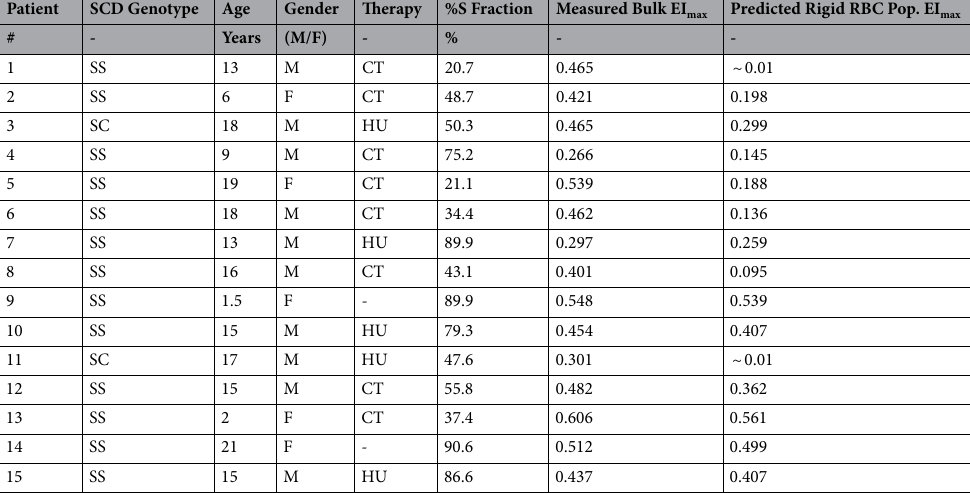
EIs obtained for healthy blood samples and the predicted maximum EIs of only the HbS (rigid) fraction for each patient’s blood. We observed a very narrow range in maximum EI of healthy blood measurements, while a maximum EIs of the raw SCD patient and healthy blood. From this data, we calculated ratios that compare the estimated maximum EIs of the sickle population in the patient blood samples to (1) the maximum EI in a healthy blood sample and (2) the maximum EI of the bulk SCD patient blood sample. A ratio value higher than unity suggests that the maximum EI of the rigid RBC population is much lower than what is measured by bulk blood measurement, thus underestimating the stiffness of the HbS population, i.e., sickled RBC, in an SCD patient.